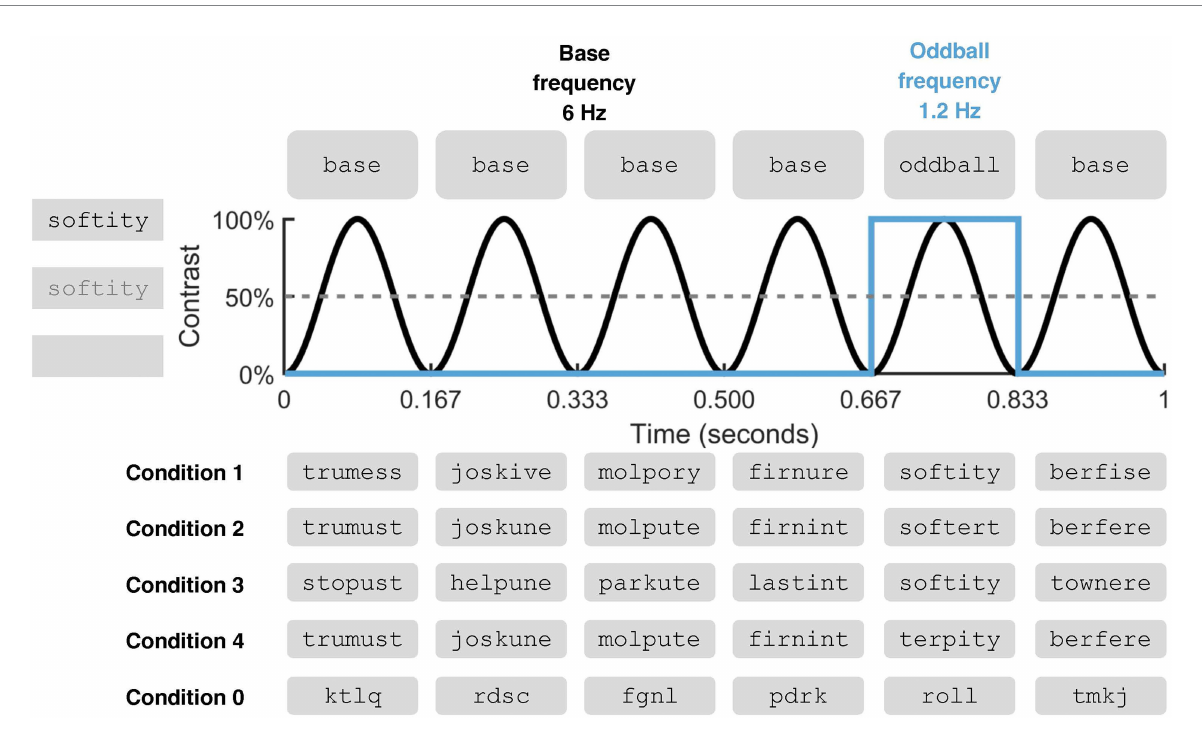
FIGURE 1 Fast Periodic Visual Stimulation (FPVS) in the context of an oddball paradigm (figure adapted from De Rosa et al., 2022). The schematic illustration pertains to one second of stimulation. For a gradual and smooth transition between them, stimuli were presented via sinusoidal contrast modulation at 6 Hz during 60 s, with each cycle reaching full contrast after 83.5 ms and lasting a total of 167 ms. Oddball stimuli appeared every fifth item (6/5 = 1.2 Hz). Examples are given for the different types of sequences used in the experimental conditions. To examine stem identification, Condition 1 featured stem + suffix oddballs embedded in a stream of nonstem + suffix pseudowords, and Condition 2 (adult sample only) featured stem + nonsuffix oddballs embedded in a stream of nonstem + nonsuffix pseudowords. To examine suffix identification, Condition 3 featured stem + suffix oddballs embedded in a stream of stem + nonsuffix pseudowords and Condition 4 (adult sample only) featured nonstem + suffix oddballs embedded in a stream of nonstem + nonsuffix pseudowords. A manipulation-check condition (Condition 0) was administered to all participants and examined a selective neural response to words that appeared as oddballs within a sequence of unpronounceable letter strings. During stimulation, participants engaged in the independent task of monitoring and responding to changes in the color of a fixation cross at the center of the